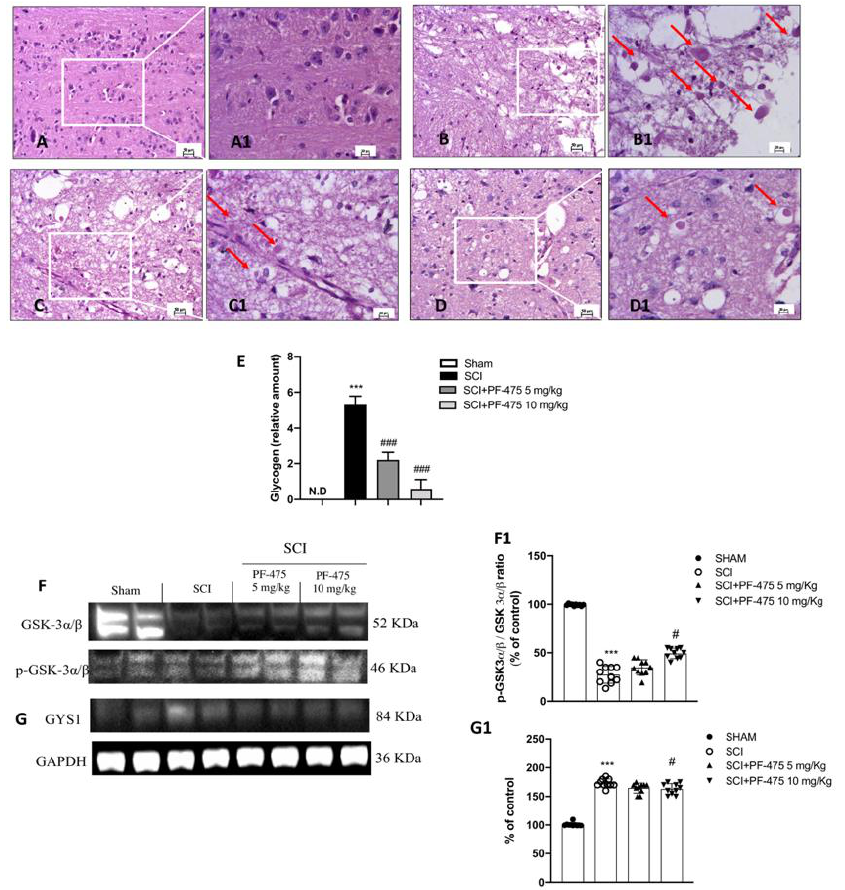
Figure 2. Effects of PF-475 on glycogen metabolism alterations after SCI. Sham group ( A , A1 ). SCI group ( B , B1 ). PF-475 treatments after SCI 2.5 and 5 mg/kg (( C , C1 , D , D1 ), respectively). Glycogen relative amount ( E ). *** p < 0.001 vs. Sham; ### p < 0.001 vs. SCI. Cytosolic fractions of spinal cord tissues were used to evaluate glycogen metabolism. Representative Western blots of GSK-3 α / β and GYS1 protein expression levels after SCI and PF-475 treatments (( F , G ) and densitometric analysis ( F1 , G1 ), respectively). Each data is expressed as SD from ten mice for each group. One-way ANOVA followed by Bonferroni post-test. (ND) Not detectable. *** p < 0.001 vs Sham; # p < 0.05 vs SCI. The samples used derive from the same experiment and those gel/blots were processed in parallel.